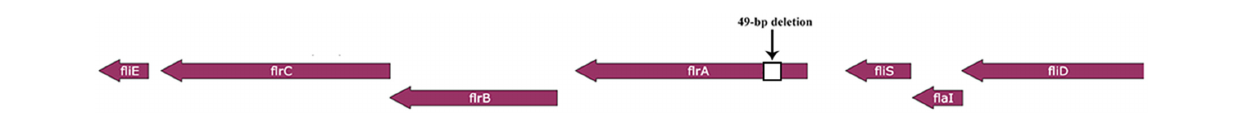
∼ 1,000-fold down regulation of flrA gene (Jubair et al.,